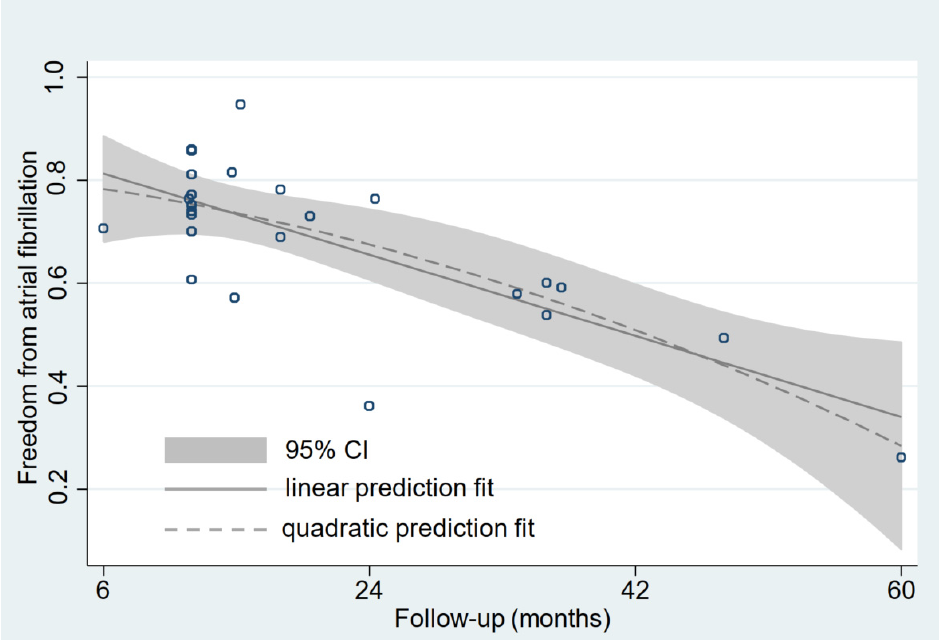
Figure 6. Linear and quadratic prediction fit plot with confidence interval between the follow-up time and the rate of freedom from AF for the elderly. The solid gray line represents the linear prediction fit. The dotted gray line represents the quadratic prediction fit. The gray area represents the 95% confidence interval for the quadratic prediction fit. Each dark blue circle represents a sample. AF: atrial fibrillation; CI: confidence interval.